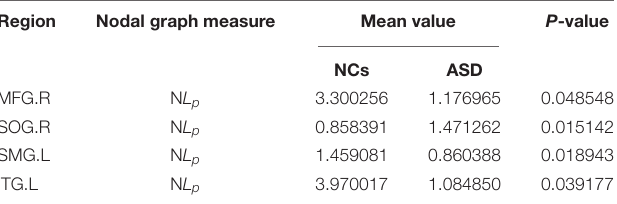
TABLE 9 | Between-group comparison in N L p